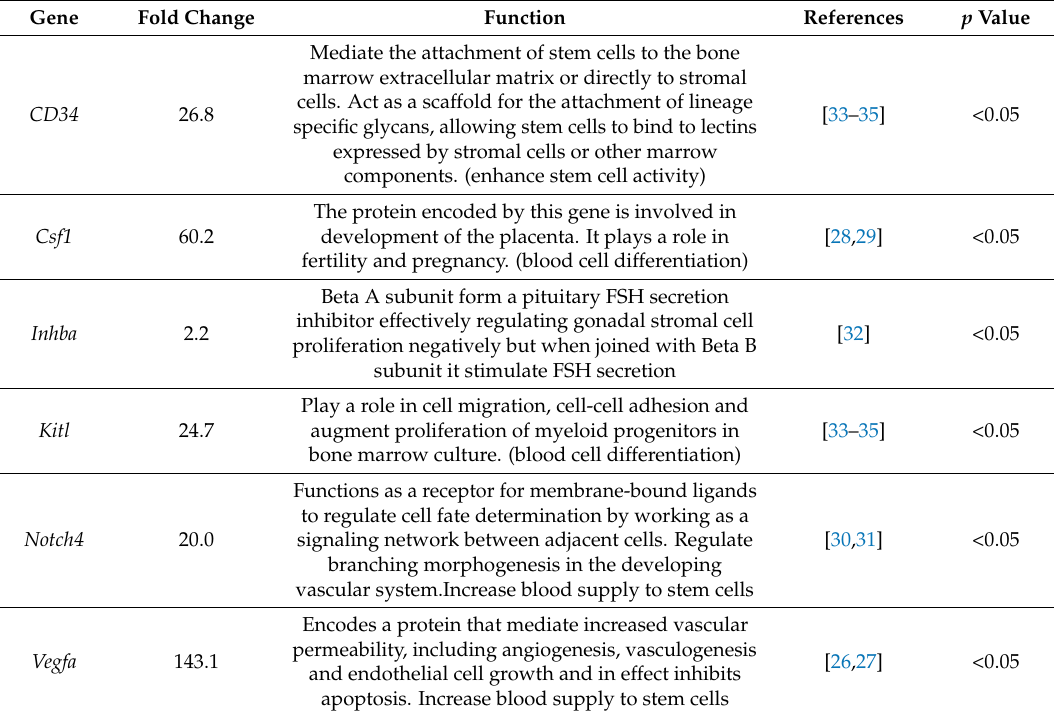
Table 1. Ovarian expression of stem cell markers evaluated by real-time PCR and compared between mice group treated with PBMC and untreated controls (CTX only and negative control) ( p < 0.05). Gene Fold Change Function p Value